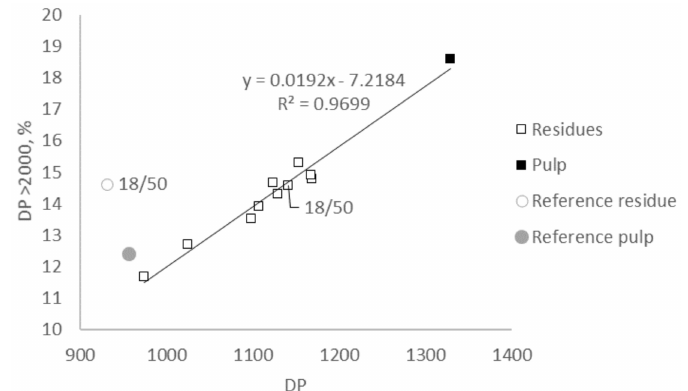
Figure 3. Correlation of degree of polymerization (DP) and fraction of material with DP > 2000 as determined with GPC-MALS after alkaline extraction of hardwood kraft dissolving pulp with 17–20 wt% aq. NaOH at 40–50 ◦ C. The reference pulp (a hardwood kraft dissolving pulp with lower viscosity but identical chemical composition) and its residue after extraction with 18 wt% aq. NaOH at 50 ◦ C is according to Fechter et al.